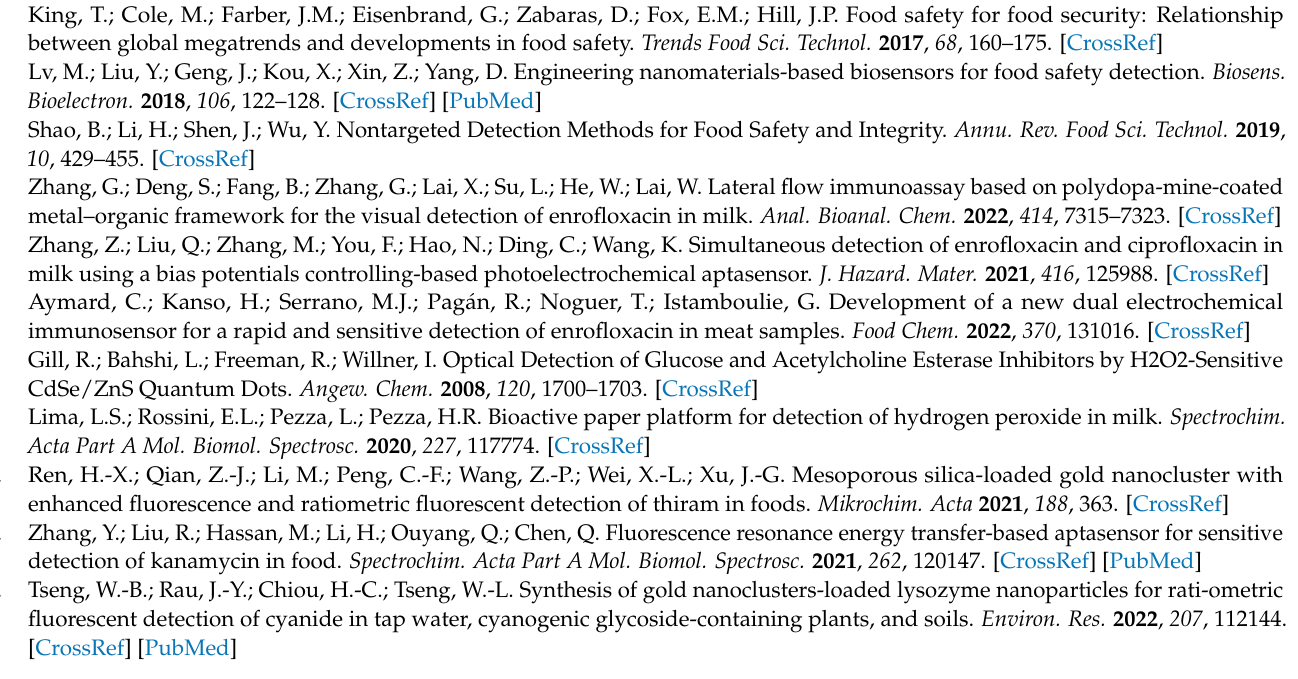
Figure S1: Particle size distribution of GSH-CdTe QDs; Figure S2: Figure S2 Visualized results of GSH- CdTe QDs with or without MnO2 NSs under (A) Sun light and (B) UV light; Figure S3 The selectivity of GSH-CdTe QDs; Figure S4: Plots of fluorescence values versus H 2 O 2 concentrations; Figure S5: Optimization of coupling conditions for fluorescent sensing probes; Figure S6: Chromatography results of fluorescent quenching probes in different buffers. From left to right: 20 mM of PBS, 30 mM of MES, NaCO 3 -NaHCO 3 buffer, PBST, 20 mM of HEPES; Figure S7: Chromatography results of fluorescent quenching probes in different concentration of HEPES. From left to right: 10 mM, 20 mM, 50 mM and 100 mM of HEPES. Tables: Table S1 Specificity analysis of ENR-Ab, Table S2 Comparison of the analytical performance of the FQISs with the commercial ELISA test kit to detect enrofloxacin in animal origin food